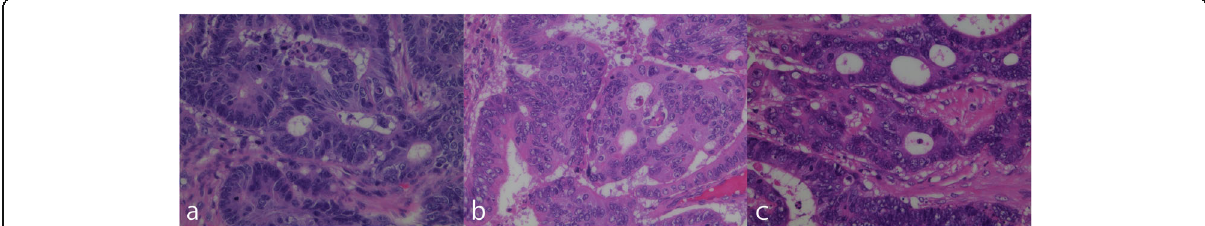
Fig. 7 Histological comparison of resected specimens from the transverse colon ( a ), rectum ( b ), and right ovary ( c ) (HE staining; magnification ×200). Rectal and ovarian tumors shared many similarities with the transverse colon cancer in terms of architectural and cytological atypia. HE, hematoxylin and eosin